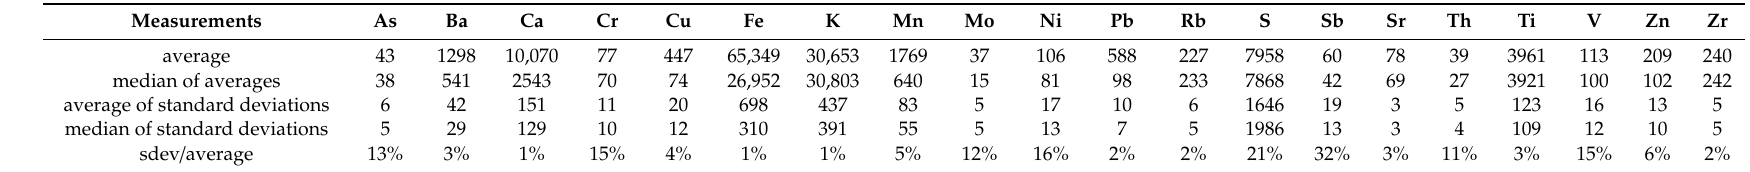
Table 6. Replicate pXRF measurement statistics (in triplicates, in mg /